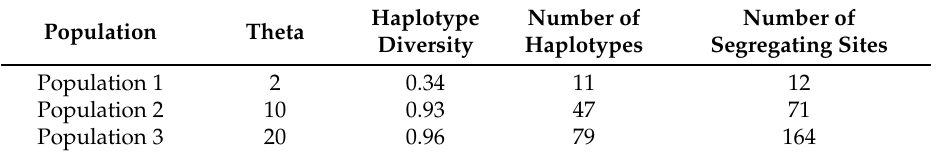
Table 1. Summary information on the simulated “field” populations that were used in this study. Population Haplotype Number of Number of Population Theta Diversity Haplotypes Segregating Sites Population 1 2 0.34 12 0.93 0.96 164